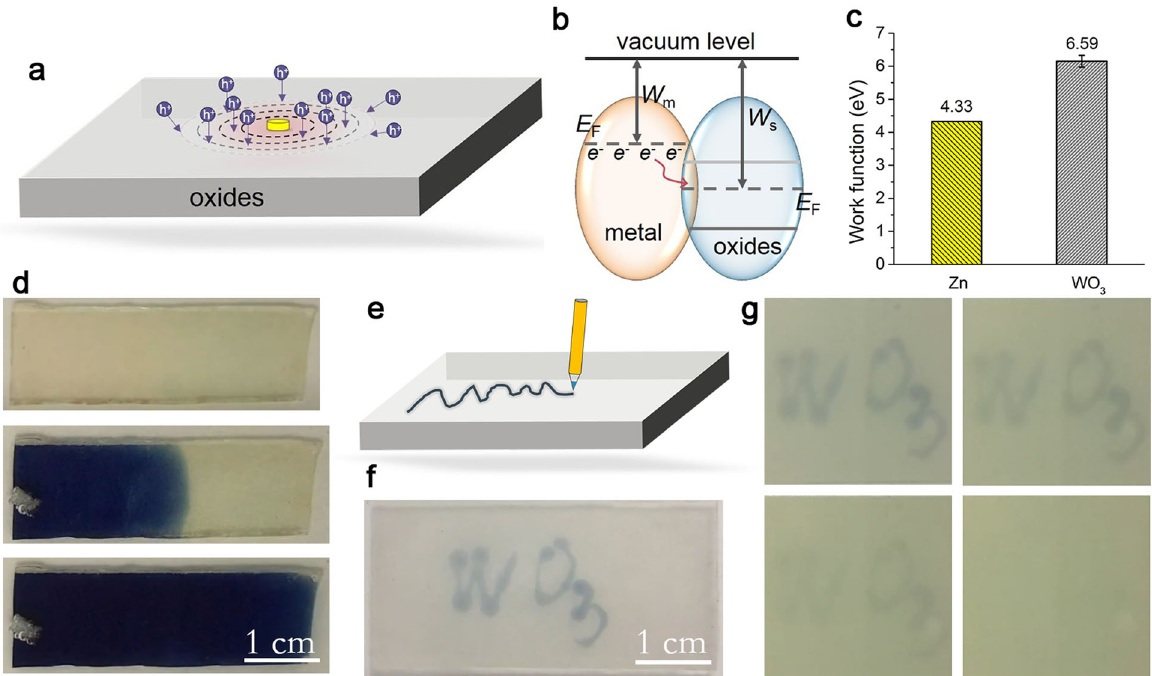
Fig. 1 The electron – proton synergistic doping for WO 3 fi lm. a The schematic diagram of electron – proton synergistic doping route. The whole system is immersed into an acid solution. The purple bubbles are free protons and the yellow column is a low-work function metal particle. b The mechanism of electron – proton synergistic doping effect: electrons fl owing from metal with a higher Fermi level (i.e., lower work function W m ) to oxide with a lower Fermi level (i.e., higher work function W s ) at the interface. c The work function values for Zn and WO 3 . d Experiments prove that Zn and WO 3 can realize the synergistic effect, which can be observed by eyesight due to the electrochromic effect. e Schematic depiction: this synergistic effect has a good spatial selection. f Sharp zinc pen was used to write “ WO 3 ” in WO 3 fi lm in acid solution. g This synergistic effect is reversible by 300 °C annealing in air.